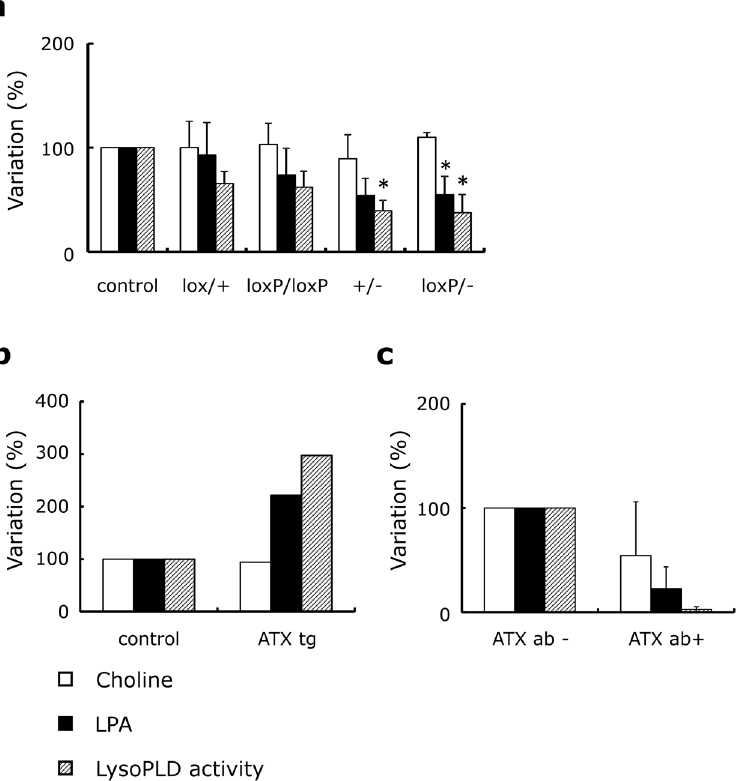
Figure 3. Plasma choline, LPA and serum LysoPLD activity in ATX knock out or overexpression mice. Plasma and serum samples were collected from each type of genetically modified mouse: control (n = 7), lox/ + (n = 5), loxP/loxP (n = 9), + / − (n = 2), and loxP/ − (n = 4) mice ( a ), control or ATX transgenic (ATX tg) mice (n = 1, each) ( b ), or anti-ATX antibody treated (ATX ab + ) or untreated (ATX ab − ) mice (n = 3, each) ( c ). The concentrations of choline and LPA in the plasma and the activities of LysoPLD in the serum were measured. Results are given as the mean ± SD of the percentage of the value in the control. * P < 0.05 versus